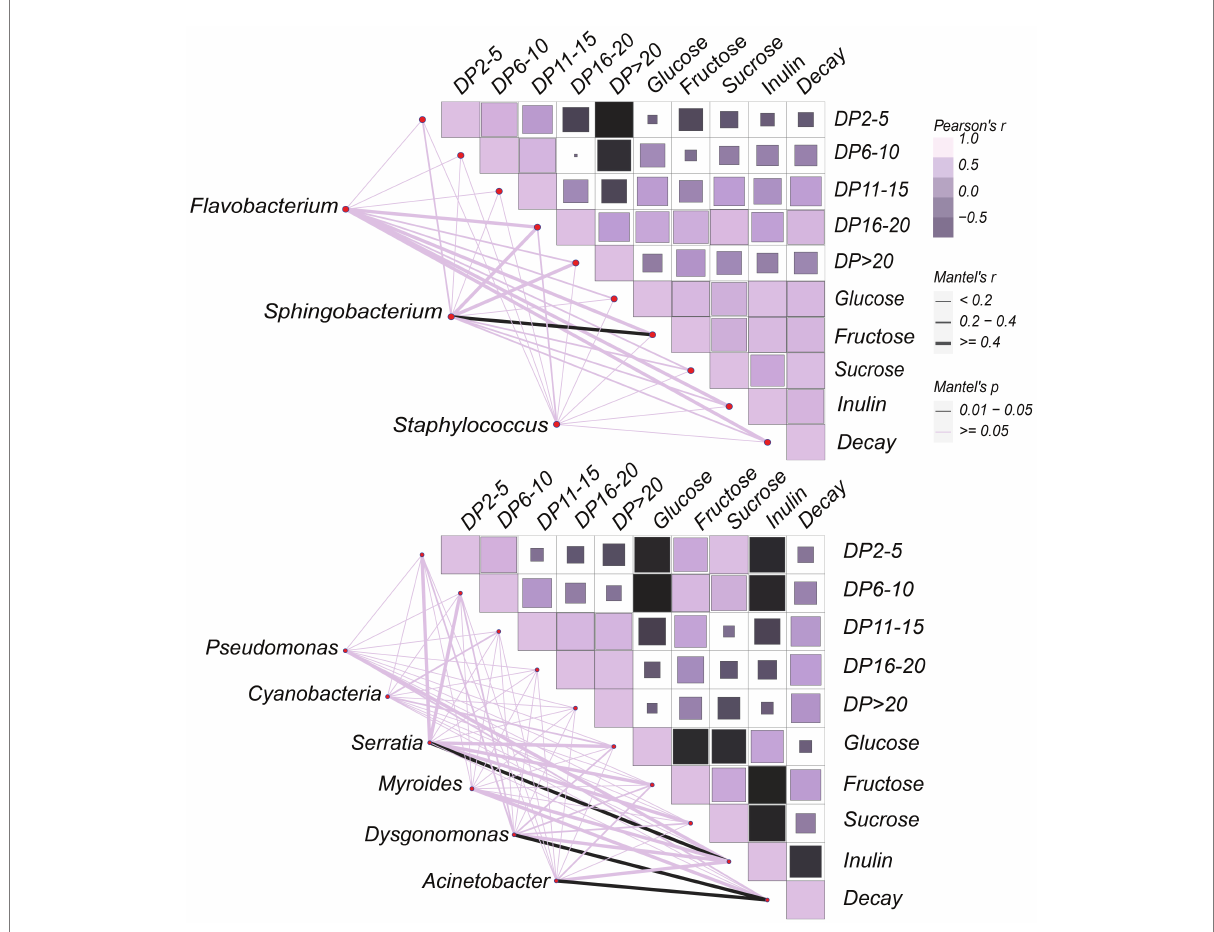
FIGURE 7 Correlation between bacterial communities and carbohydrates on the surface of Jerusalem artichoke tubers during storage. The horizontal and vertical axes of the heat map on the right side represent the various types of carbohydrate factors that respond to or interact with the community, respectively. The color of the block in each square of the heat map indicates a positive or negative correlation with carbohydrate factors, and its size indicates the absolute value of the correlation coefficient. The shading from dark purple to light purple indicates a positive correlation gradient from low to high, and the shading from dark purple to black represents a negative correlation gradient from low to high. On the left side is the bacterial data obtained from LEfSe analysis, which are linked to each carbohydrate factor data one by one through connecting lines. The edge width corresponds to the R value and edge color denotes the statistical